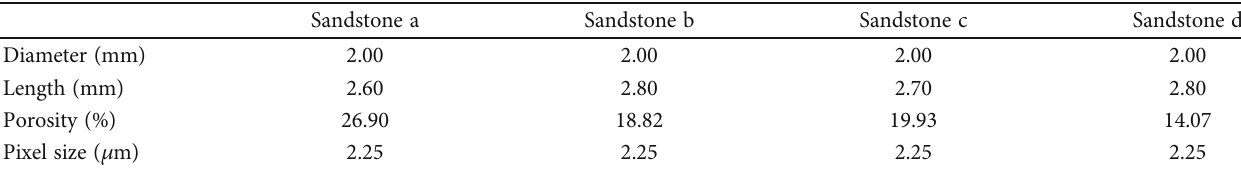
Figure 6: Method for analyzing pore-throat parameters: (a) ray emits in cutting plane; (b) maximum sphere method; (c) length of throat measurements; (d) throat section (blue plane). Table 1: Scanning parameters of each core